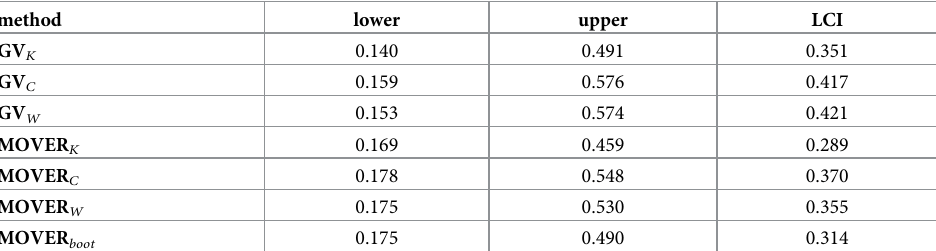
Table 4. Estimated confidence interval for Virginia ground water well yields data (in gal/min/ft).